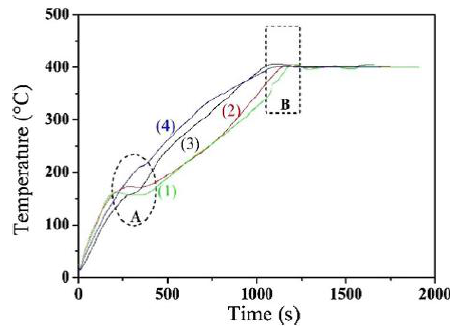
Figure 4. MW heating curves of different catalyst precursors: ( 1 ) Ni-Mn/Al 2 O 3 , ( 2 ) Ni-Mn-Re/Al 2 O 3 , ( 3 ) Re-Al 2 O 3 , and ( 4 ) Ni-Mn/Re-Al 2 O 3 . Reprinted from Appl. Catal. A Gen. , 552, Dong, X.; Jin, B.; Sun, Y.; Shi, K.; Yu, L., Re-Promoted Ni-Mn Bifunctional Catalysts Prepared by Microwave Heating for Partial Methanation Coupling with Water Gas Shift under Low H 2 /CO Conditions. Copyright (2018) with permission from Elsevier.